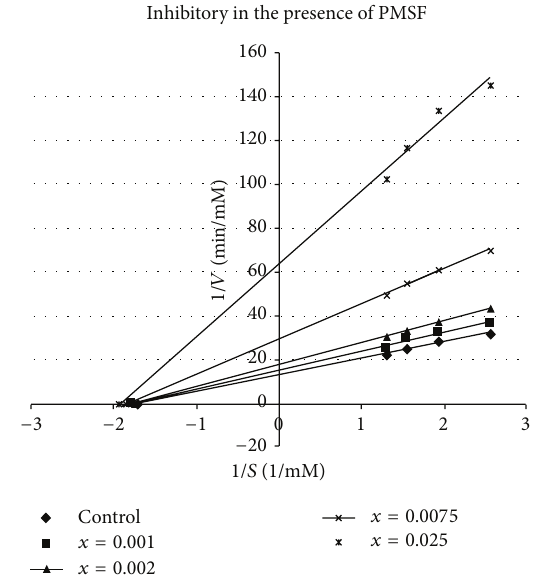
Figure 2: Determination of apparent kinetic parameters ( 𝐾 app 𝑚 , 𝑉 󸀠 𝑚 ) for PMSF.